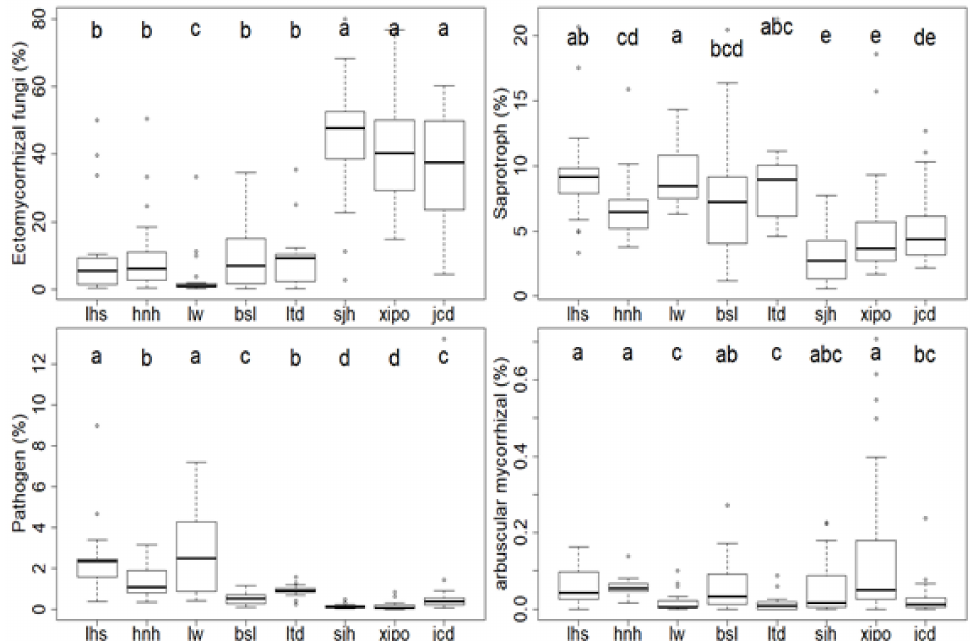
Figure 5. Fungal function groups along the elevation gradient. Function groups include ectomycor- rhizal (EM), saprotroph, arbuscular mycorrhizal (AM), and pathogen. Different letters (a–e) indicate significant differences between the three different disturbance levels.